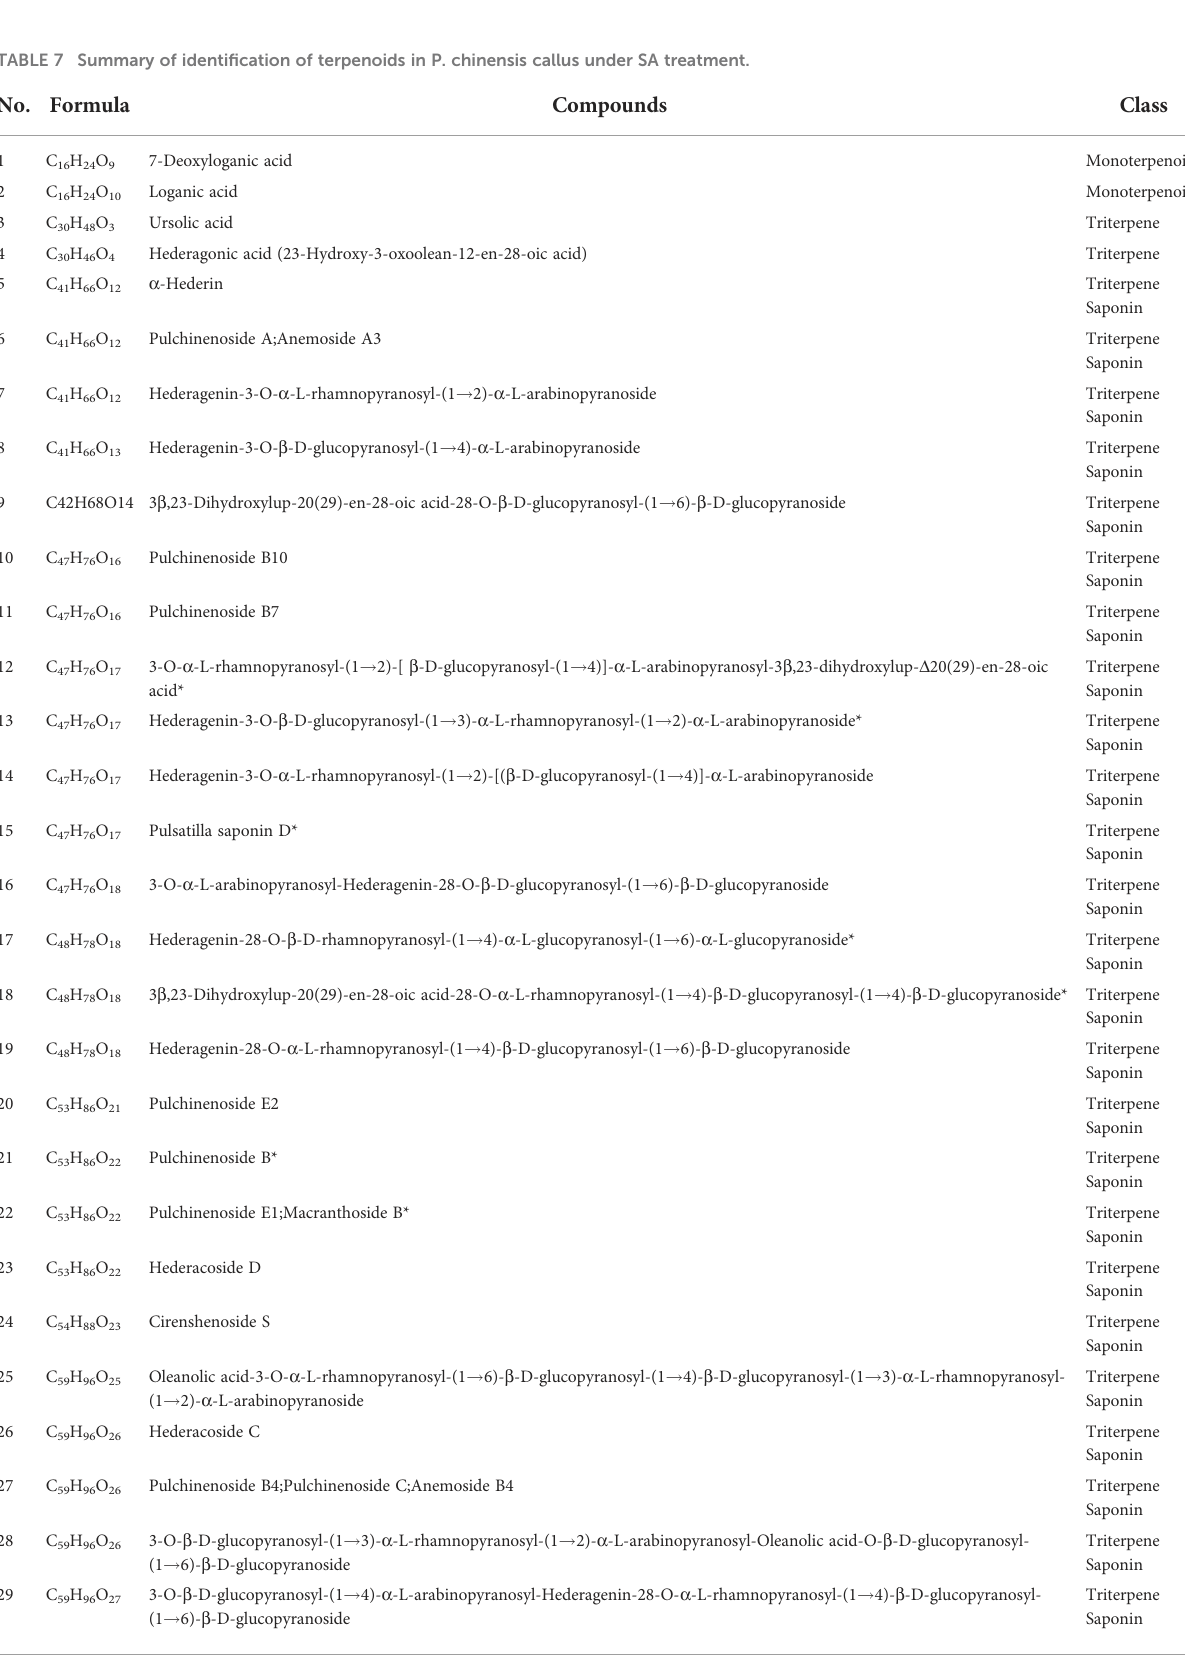
TABLE 7 Summary of identi fi cation of terpenoids in P. chinensis callus under SA